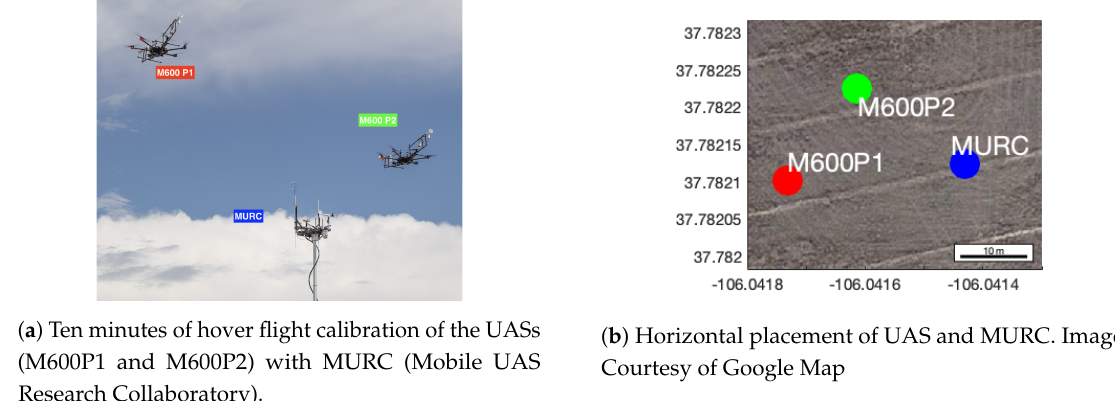
Figure 5. MURC tower calibration.